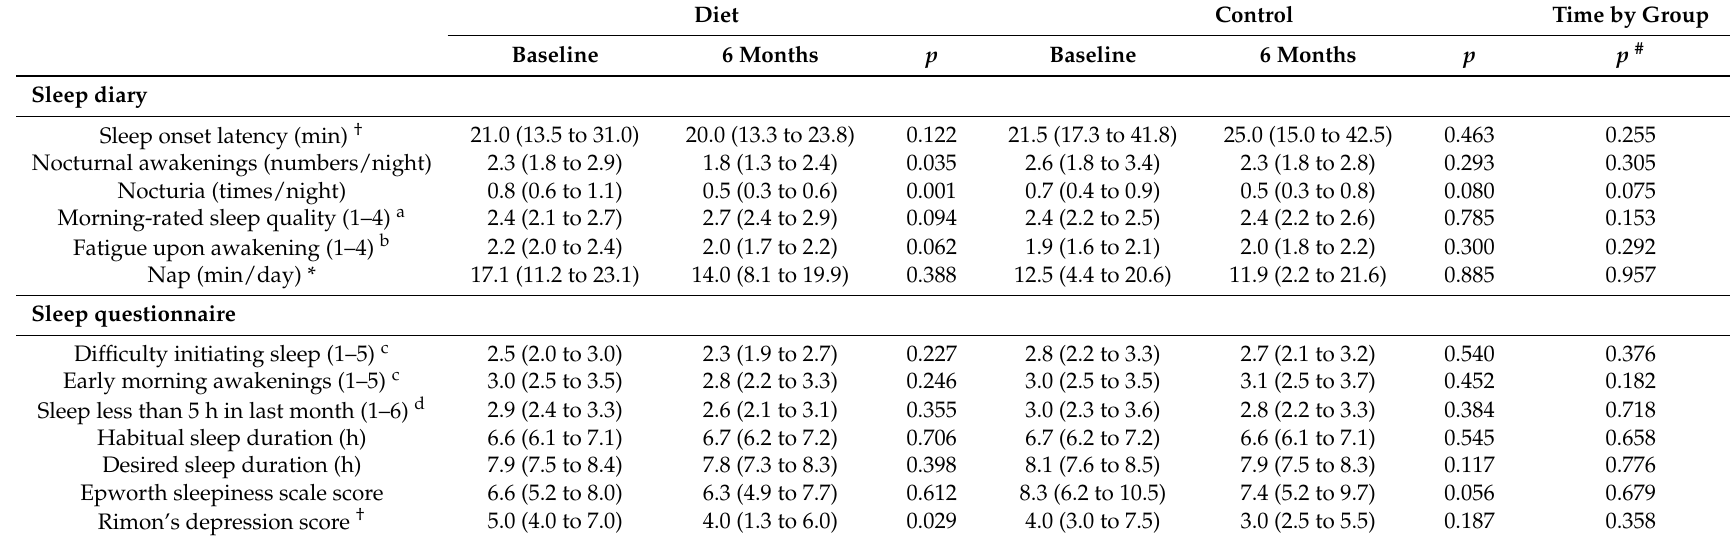
Table 3. Sleep outcomes by sleep diary and sleep questionnaire at baseline and six